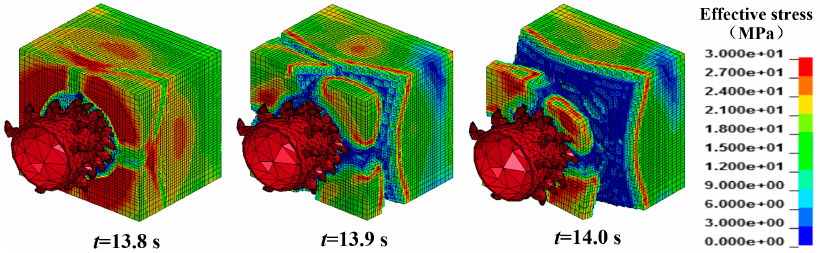
Figure 24. Fragmentation process of rock with five holes under the confining pressure of 20 MPa.